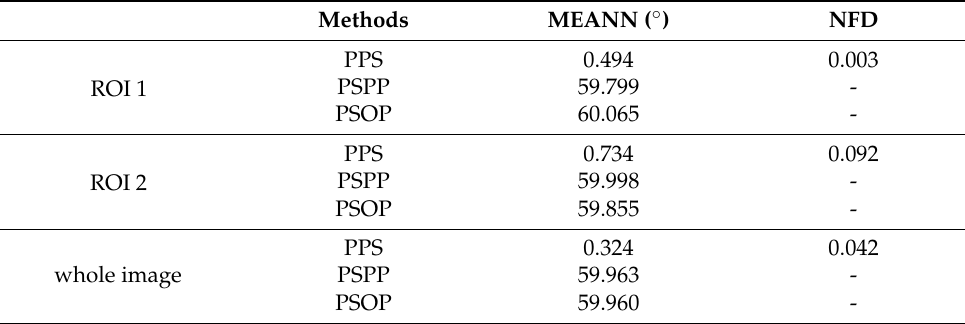
Table 2. Quantitative measures of three methods for the simulated images.